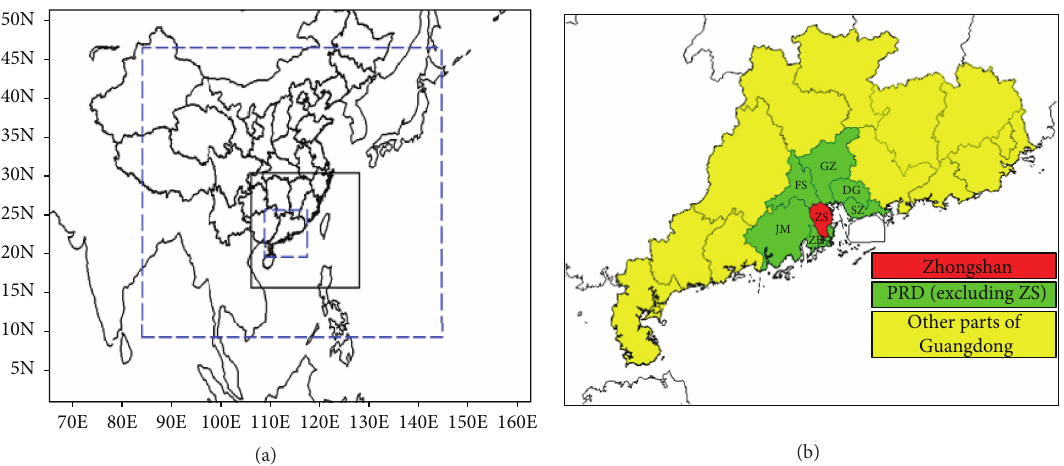
Figure 1: (a) Two-nested modeling domains for WRF (black solid boxes) and CMAQ (blue dashed boxes) models. (b) The inner CMAQ domain with three emission source regions and the major cities in the PRD region (cities in the PRD: Zhongshan (ZS), Guangzhou (GZ), Foshan (FS), Jiangmen (JM), Zhuhai (ZH), Dongguan (DG), and Shenzhen (SZ)).